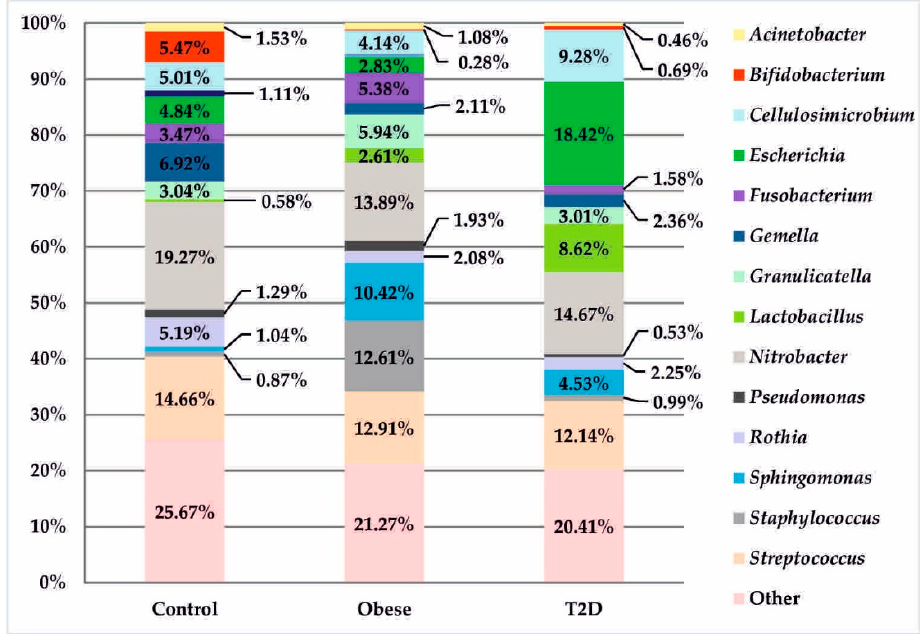
Figure 5. Bacterial profiles in the treatment and control groups at the genus level.